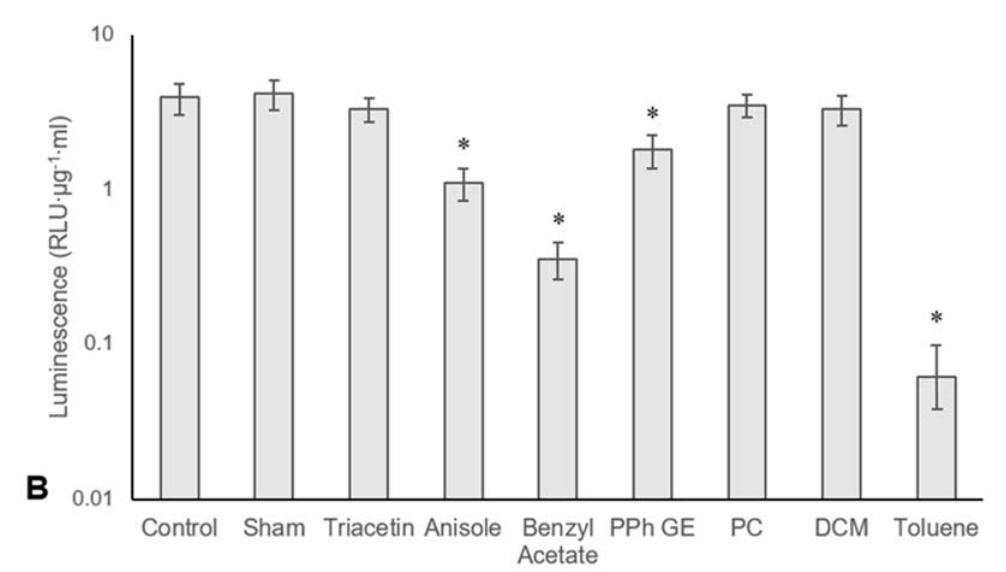
Figure 4. Mean average luminescence, represented as relative light units adjusted for protein concentration, measured after lysis of cells incubated with solvent-exposed MVA ( A ) or Ad ( B ). Welch’s ANOVA and Games–Howell’s post-hoc tests were used to make statistical comparisons. A p -value of less than 0.05 was considered statistically significant and indicated by an asterisk. Error bars represent the standard deviation, n = 3.